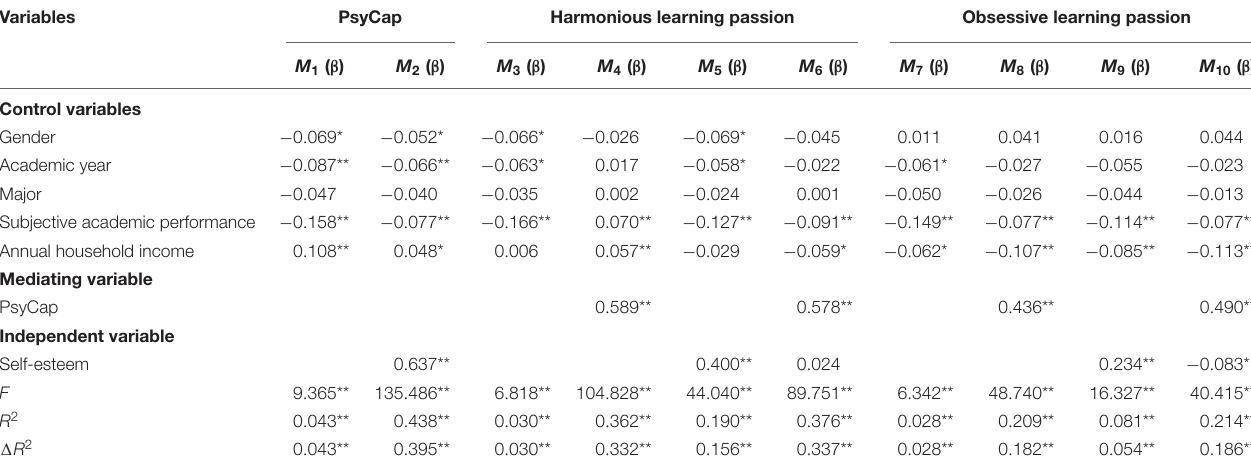
TABLE 3 | Hierarchical linear regression analysis models ( N = 1,218). Variables PsyCap